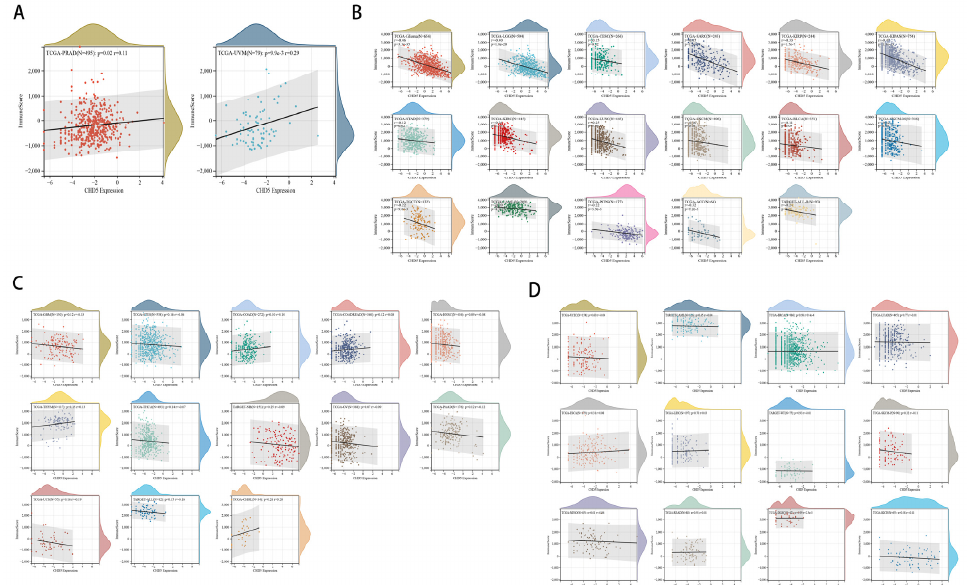
Figure A5. Correlation between CHD5 expression and pan ‐ cancer immune score. ( A ) CHD5 expression was negatively correlated with immune scores in KIPAN, SARC, Glioma, LGG, KIRP, ACC, KIRC, LUSC, ALL, TGCG, PCPG, LAML, CESC, STAD, SKCM ‐ M, BLAC and SKCM, ( B ) CHD5 expression was significantly positively correlated with the immune scores in PRAD and UVM. ( C , D ) No significant differences were found in other cancers.